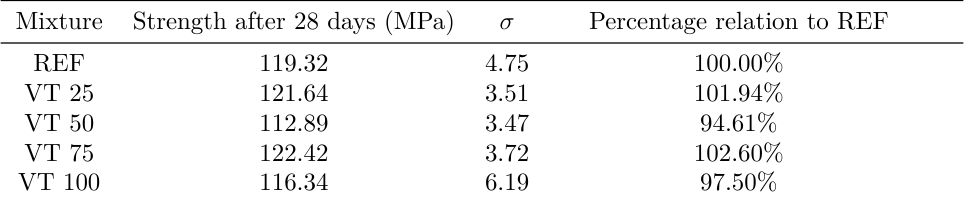
Table 3. Compressive strength (cubes 150